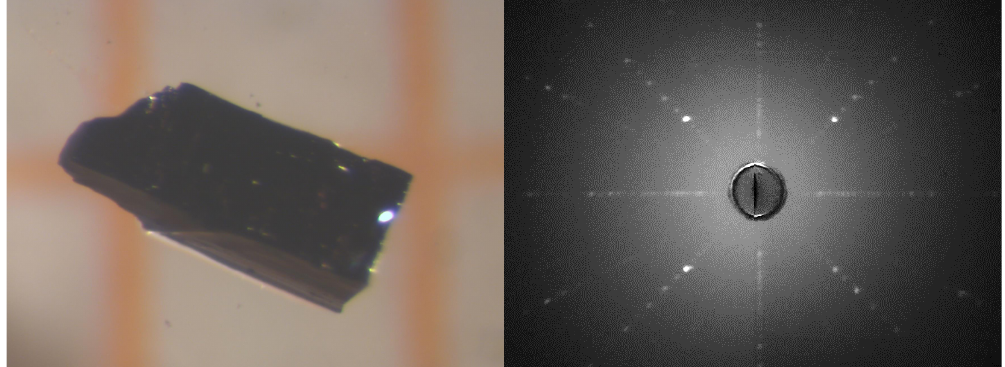
Figure 2. Li 2 Sr[(Li 1 − x Fe x )N] 2 single crystal ( x = 0.41) on a millimeter grid ( left ) and corresponding Laue-back-reflection pattern to the right showing the four-fold rotational symmetry along the crystallographic c